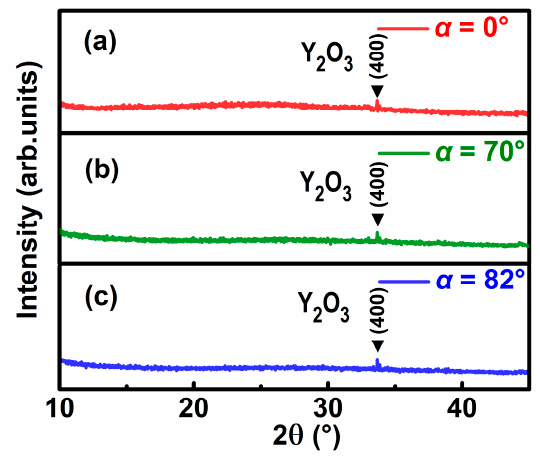
Figure 2. XRD patterns of yttrium fluoride (YF 3 ) films deposited at the angles of 0° ( a ), 70° ( b ), and 82° ( c ).